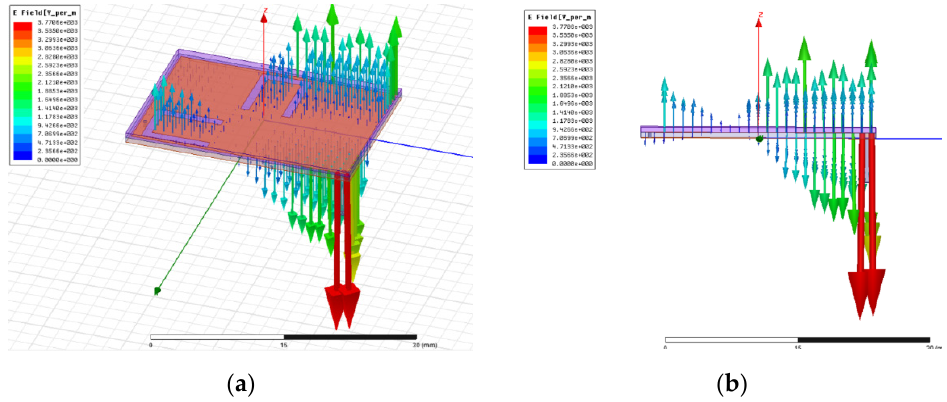
Figure 19. Electric field density of the proposed antenna at 2.45 GHz displayed in two- dimensional ( a ) and three-dimensional space ( b ). Table 3. Maximum Electric Field and Antenna Structure Modifications extracted from the simulations.